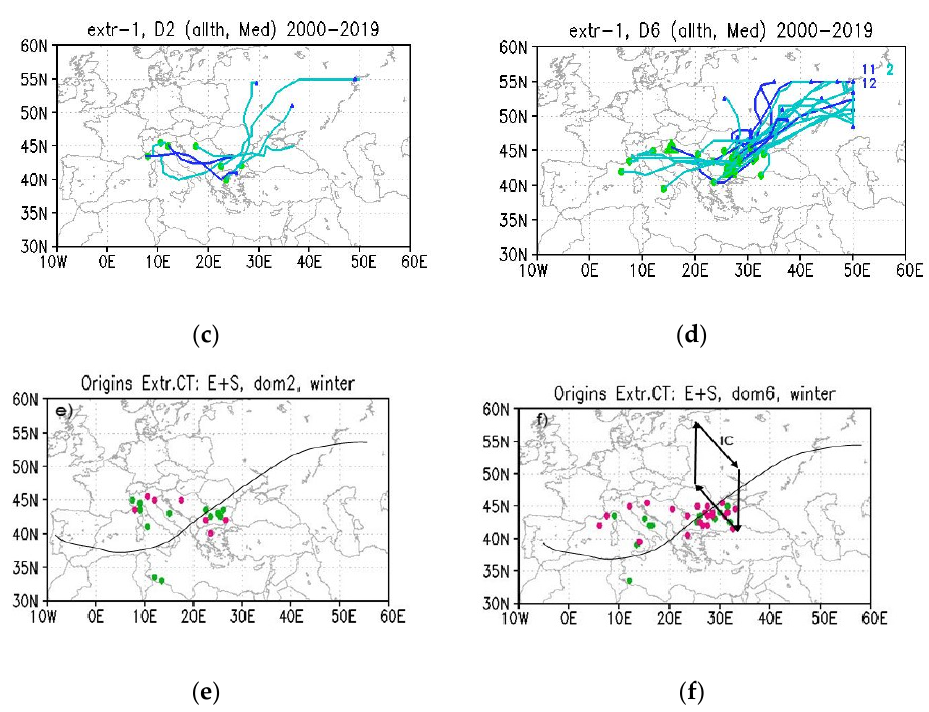
Figure 7. Tracks of extreme cyclones for P1 ( a , c ) and P2 ( b , d ) over domains: D2 ( a , c ) and D6 ( b , d ), in winter (blue lines), “Med” origins (green dot for origin). ( a – d ) Dark blue represents October, November, December autumn-originating tracks (OND); light blue represents winter (January, February and March) tracks; the month when “E” extremes reached Di is shown in the upper-right corner; in addition, “E” extremes show a full triangle mark for the origin (the “S” extremes have a full circle); ( e , f ) origins of the extreme tracks in P1 (dark green) and P2 (plum) for winter, for D2 ( e ) and D6 ( f ); black line schematizes the location of anomalous displacement of polar jet from zonality in P2 relative to P1 in months ONDJFM. The indirect circulation (IC) in the jet streak exit area is schematized in Figure 7f.